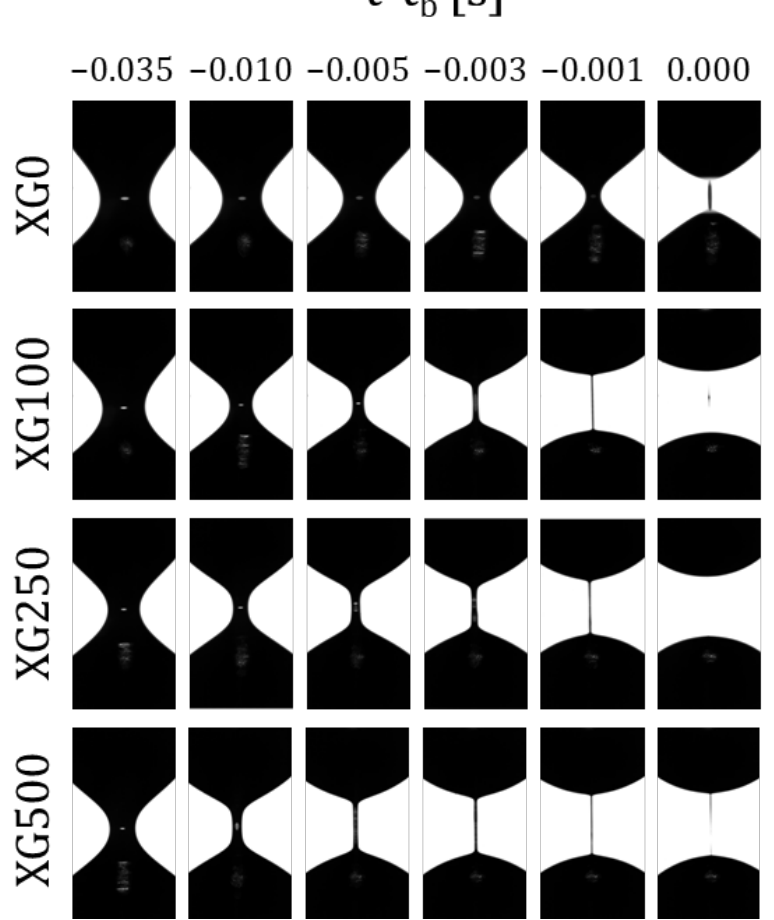
Figure 4. Last 35 ms of each filament thinning process for the different concentration of XG (0, 100, 250 and 500 ppm) at 22 ° C.